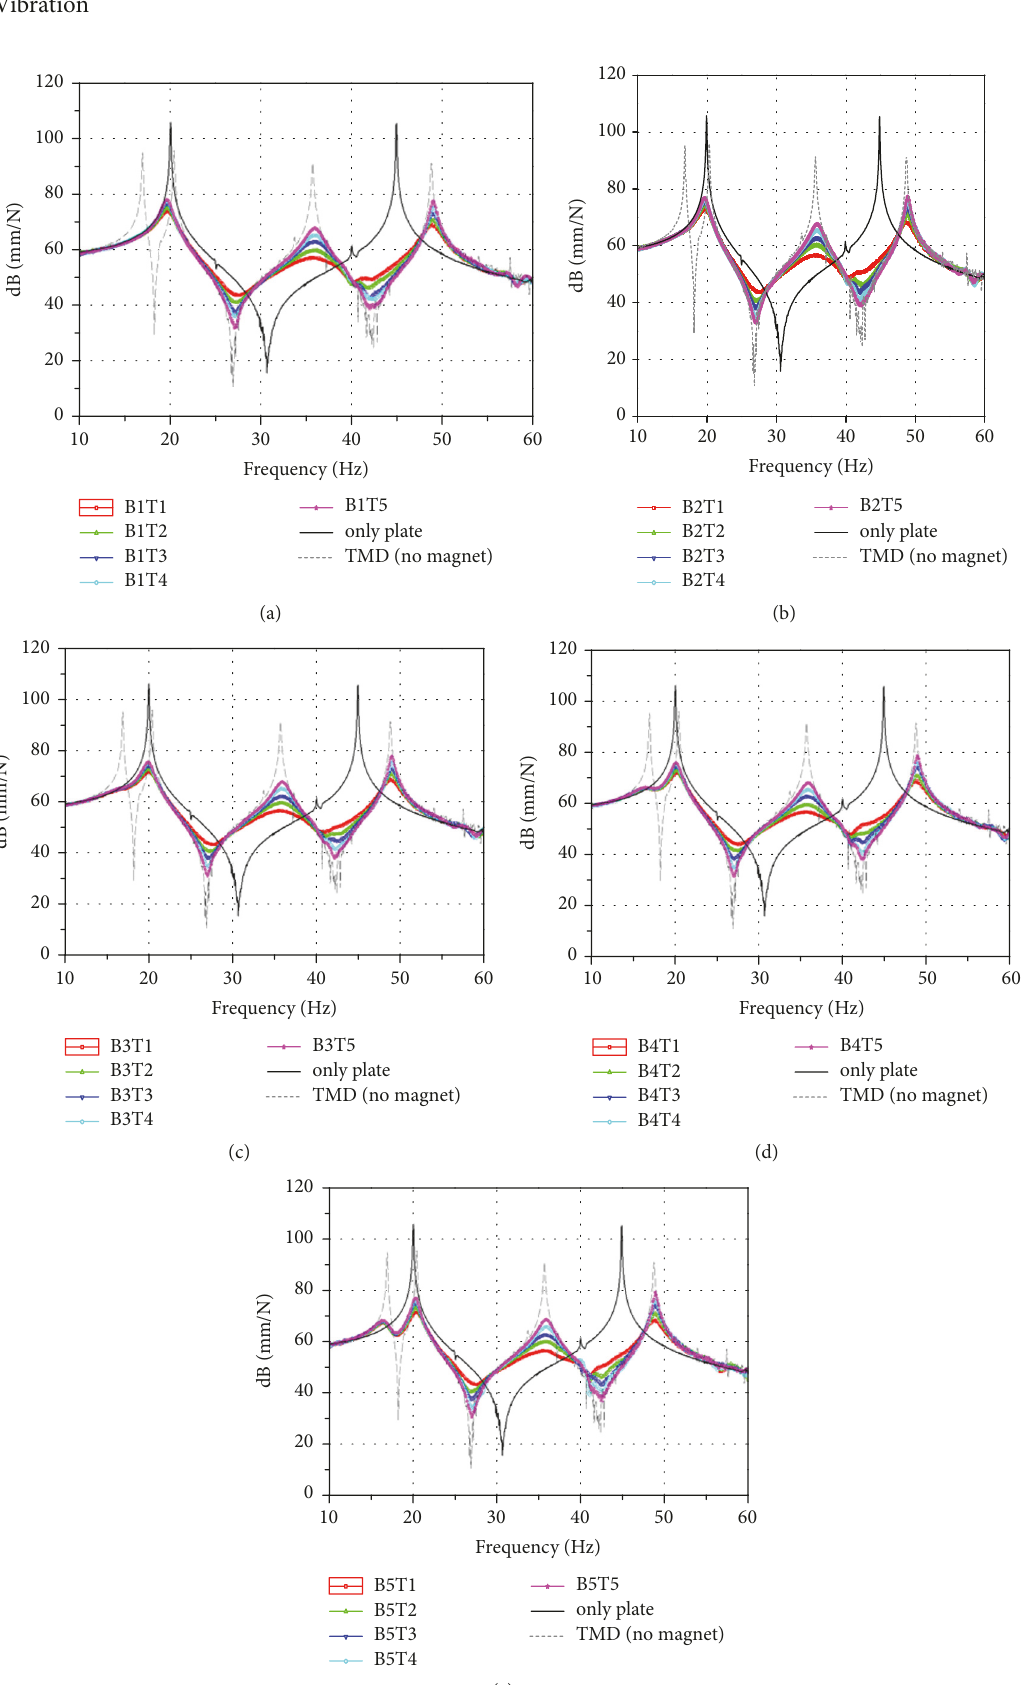
Figure 17: FRF results of mTMD with respect to the gap change when 𝜇 = 0.1 and 𝛽 = 0.85 : (a) first TMD gap at 1mm, (b) first TMD gap at 2 mm, (c) first TMD gap at 3 mm, (d) first TMD gap at 4 mm, and (e) first TMD gap at